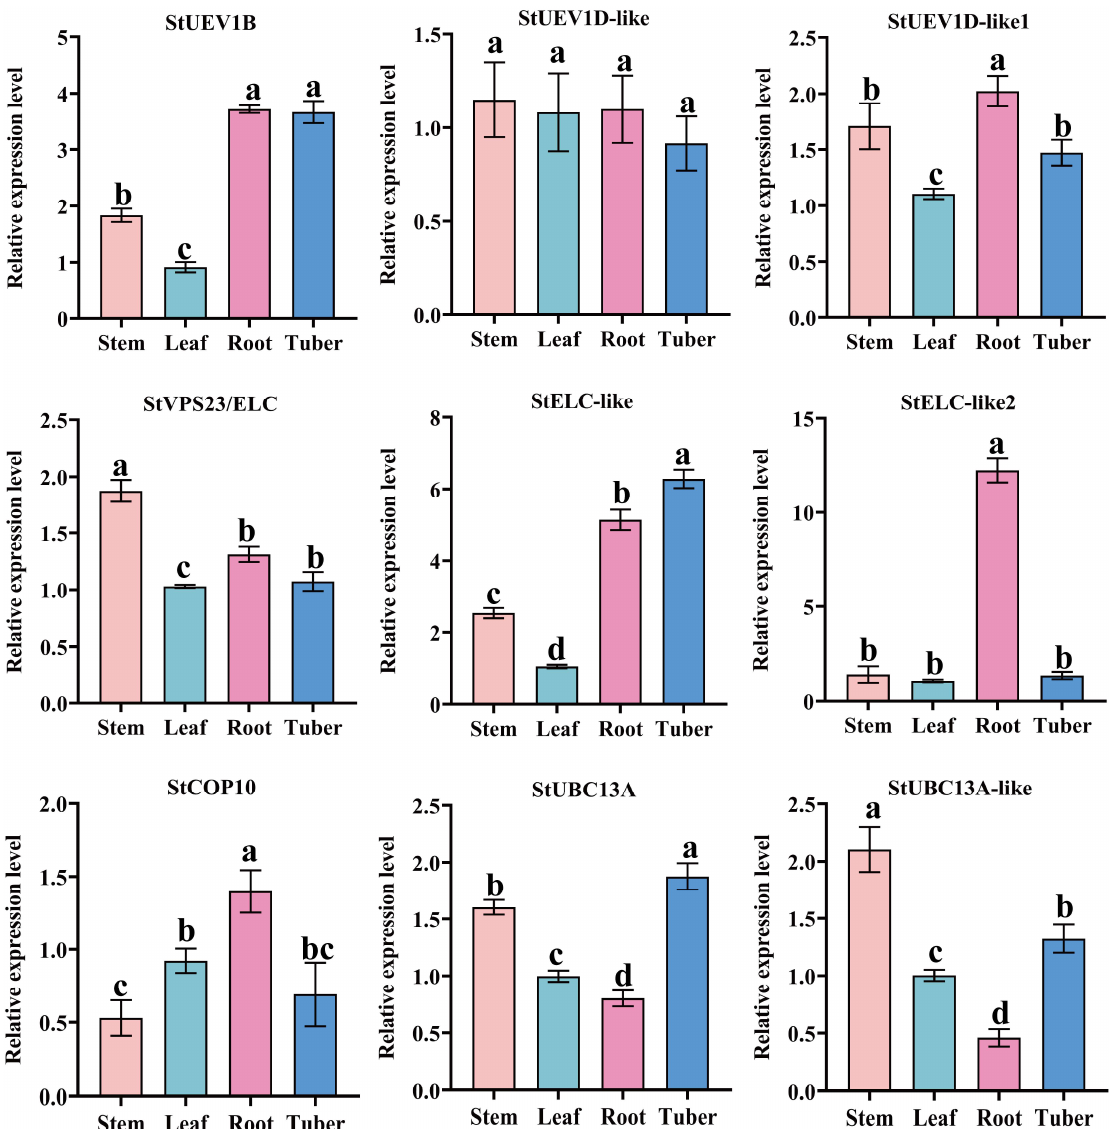
Figure 7. The qRT-PCR analysis of StUEVs and StUBC13 in different potato tissues. Different small letters indicate statistical differences of tissues when assessed using Duncan’s multiple range test ( p < 0.05, n = 3).